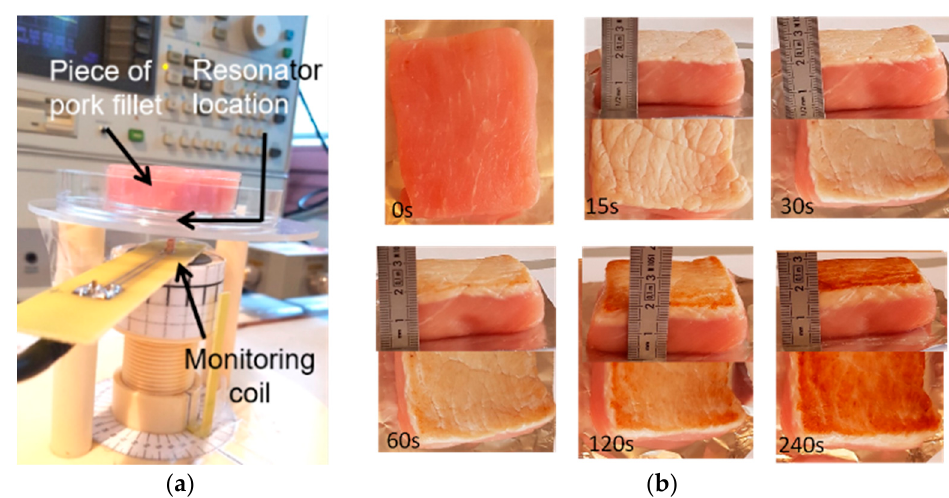
Figure 4. ( a ) Radiofrequency (RF) measurement set up; ( b ) Examples of low-fat pork filet samples, raw and burned during up to 240 s using the interrupted heating procedure.